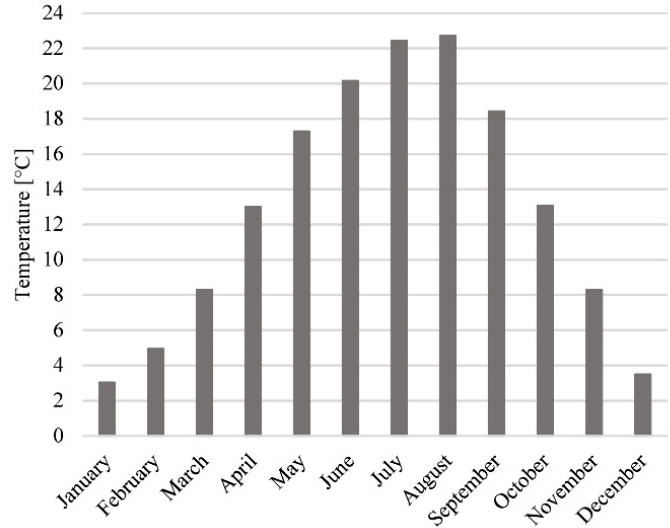
Figure 7. Mean monthly temperatures at point A in the current climate.